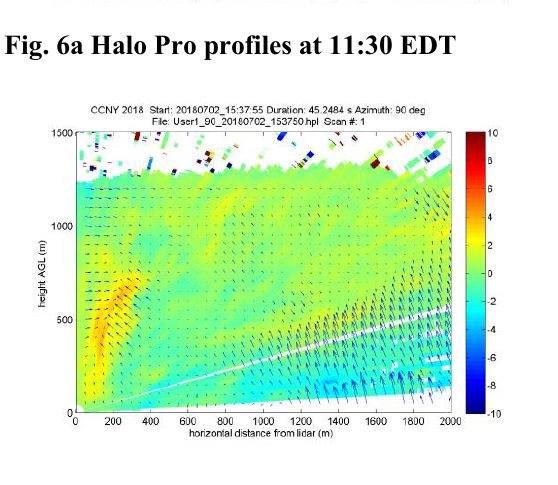
Fig. 6b Halo Streamline RHI output 11:30 EDT